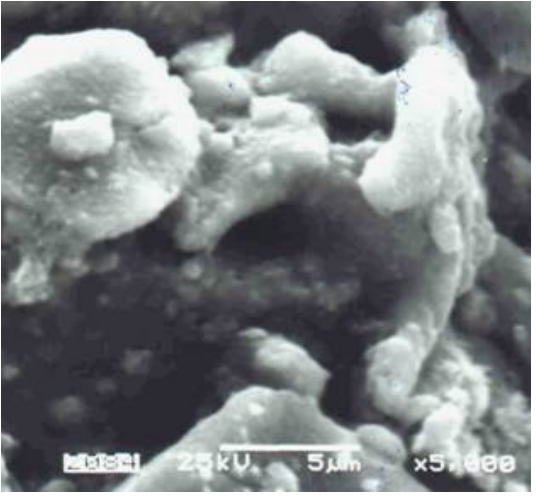
Figure 2. SEM micrograph of gas sensing layer of tin